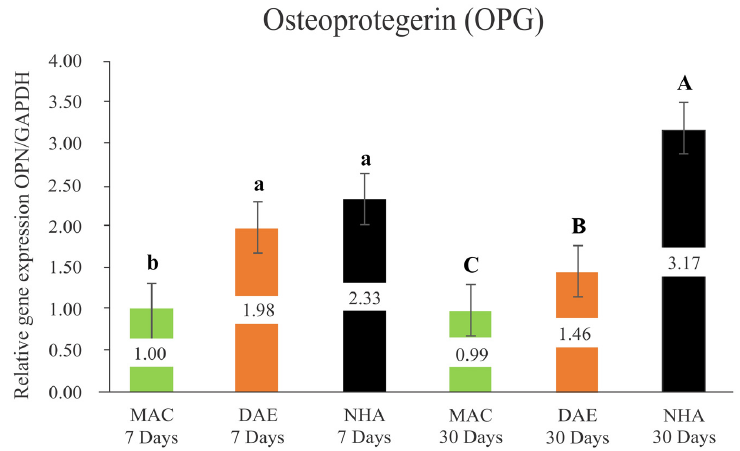
Figure 7. Relative expression of osteoprotegerin/GAPDH (OPG/GAPDH) in all groups (mean + 95% Confidence Interval). Lower case letters represent the analysis of 7 days, and capital letters the anal- ysis of 30 days. Different letters indicate a statistically significant difference between groups. There were not statistically significant differences ( p ≥ 0.05) for intragroup analyses, considering the same surface treatment and different assessment times.